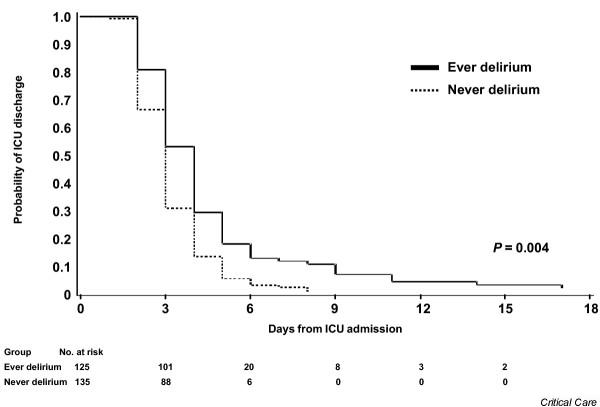
Delirium versus ICU length of stay. This Kaplan-Meier plot shows the relationship between delirium and length of stay in the ICU by classification of Ever Delirium versus Never Delirium (p = 0.004, univariate analysis).